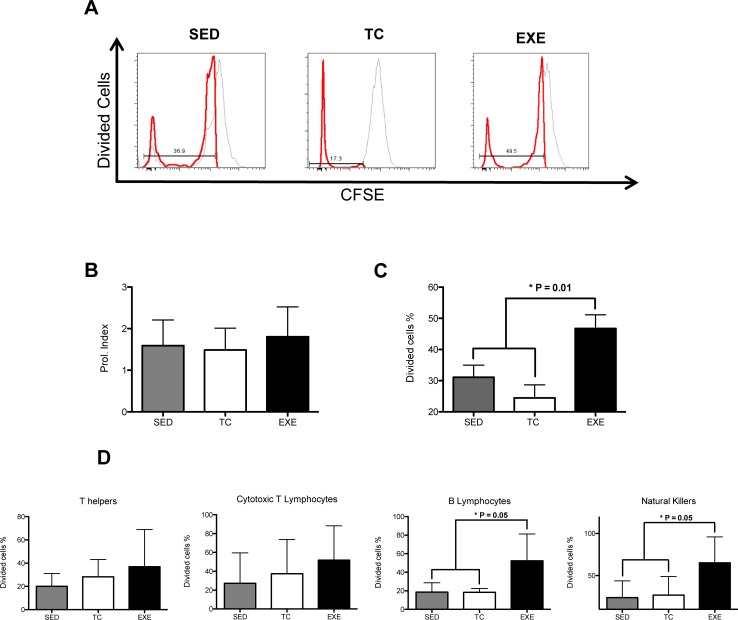
Effect of chronic exercise on splenocyte proliferation.(A) Representative histograms of cytometric analysis of dividing cells. Two parameters were considered to assess the proliferative capacity of splenocytes: (B) the proliferation index, which did not change due to chronic exercise and (C) the proportion of dividing cells, where we observed an increase in the exercised group when compared to both control groups (ANOVA, p = 0.0092, n = 5). (D) Analysis of proliferative capacity of specific splenocyte subpopulations: T helper lymphocytes (ANOVA, p = 0.4543, n = 5) and cytotoxic T lymphocytes (ANOVA, p = 0.5248, n = 6) did not show any change between groups; B lymphocytes (ANOVA, p = 0.0006, n = 6) and Natural killers (ANOVA, p = 0.0191, n = 6) from EXE did show an in increase in the proportion of dividing cells when compared to both control groups. In graphic bars SED is represented by shaded bar, TC by white bar and EXE by the solid bar.